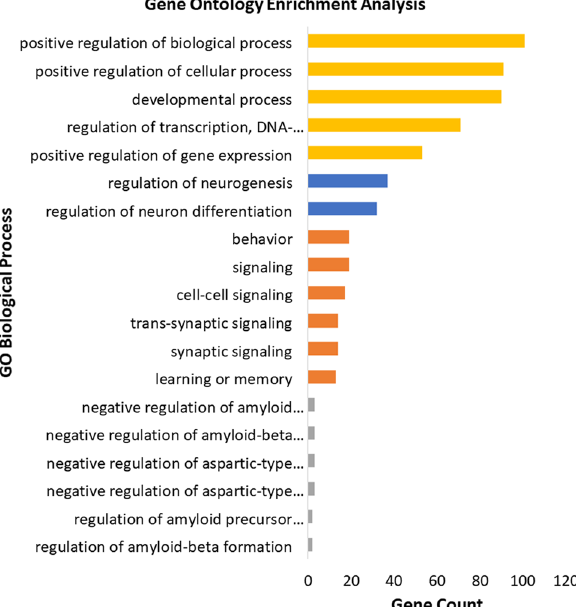
Figure 4. Gene Ontology enrichment analysis of neuropsychiatric and neurological disorders using GOrilla Enrichment. Bar plot of the 5 most significant results from Gene Ontology enrichment analysis of each neuropsychiatric and neurological datasets after the Matrix-GC. The following disorders are represented: attention deficit hyperactivity disorder (ADHD, Orange), schizophrenia (SCZ, Blue), Alzheimer’s disease (AD, Grey), Autism database (ASD-SFARI, Yellow). Full statistical results from GOrilla Enrichment can be found in the Supplementary Information files. Control permutation analysis was carried out on randomly generated and size-matched, from hg19 human reference genome and exome subset